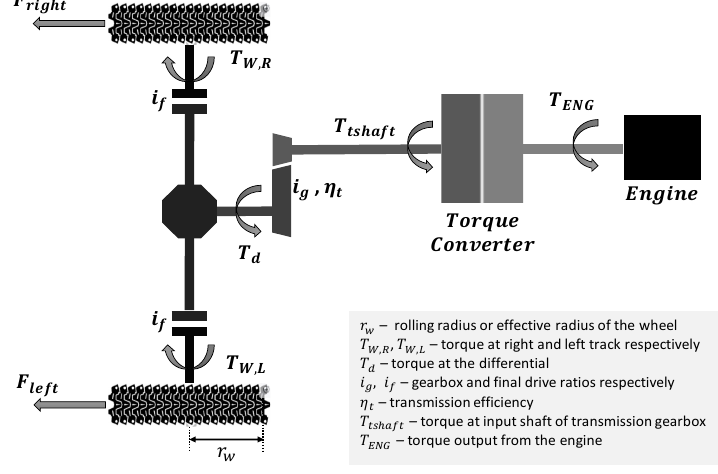
Figure 6. Simplified APC drive train schematic.